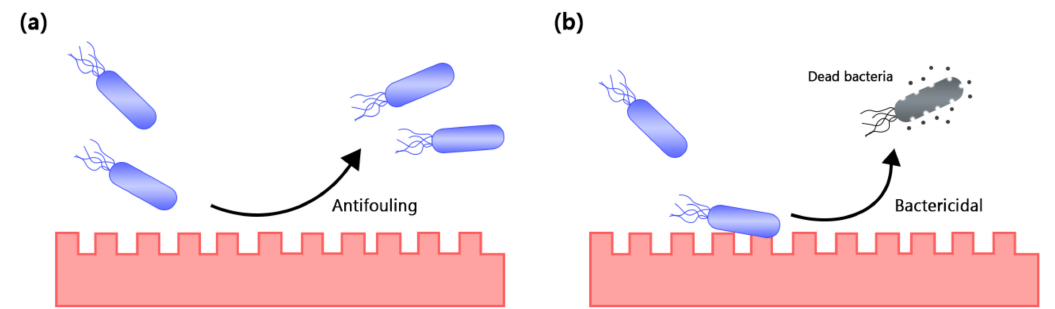
Figure 8. Schematic representation of the potential of superhydrophobic surfaces in preventing biofilm formation: ( a ) Antifouling property which minimizes the adhesion of bacterial cells onto the coated surface; ( b ) Bactericidal property which kills bacterial cells as a result of membrane rupture and/or the intrinsic antibacterial properties of coated nanomaterials by inducing oxidative stress, damaging biomolecules, depleting ATP, and interaction with bacterial